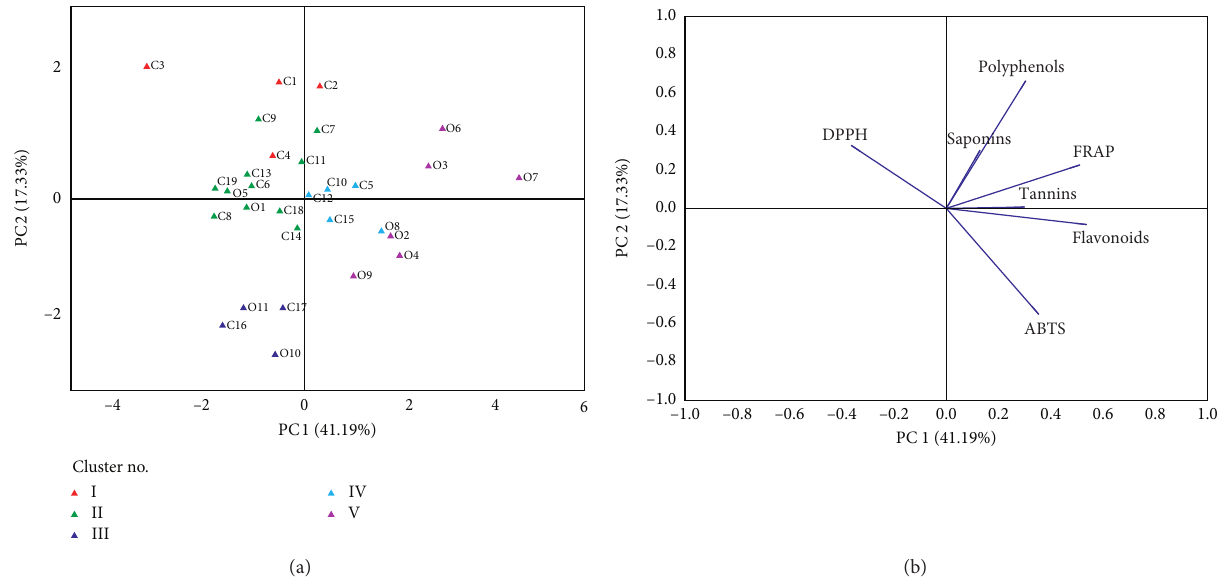
Figure 9: Principal component analysis (PCA) plots. (a) The scores plot for different genotypes of C. capsularis and C. olitorius and (b) the loading plot loading plots for different variables on PC1 and